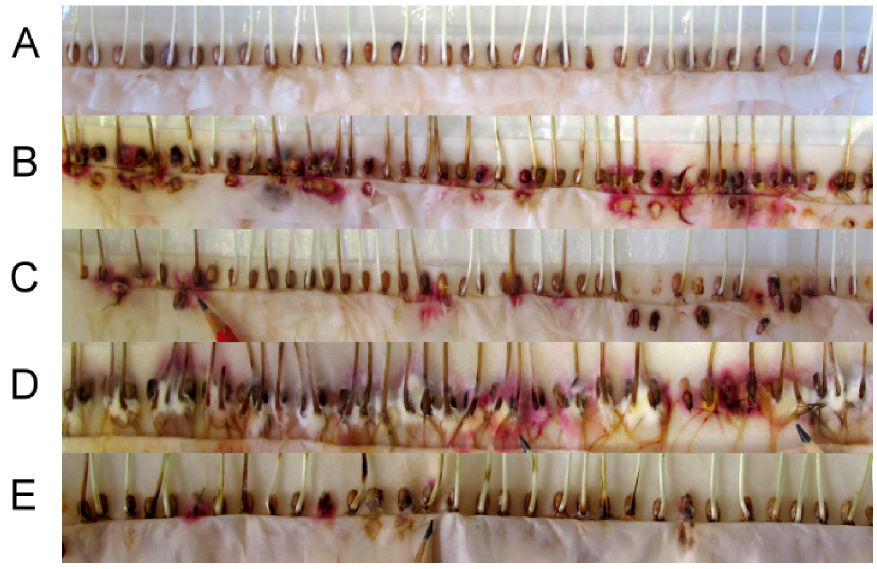
Fig 1. Inoculated and non-inoculated seedlings of cv. Bohemia under different treatment conditions. (A) non- inoculated seedlings in water, (B) inoculated seedlings in water, (C) inoculated seedlings in prochloraz, (D) inoculated seedlings in potassium iodide, (E) inoculated seedlings in sodium bicarbonate. Pink–white coloration around kernels and dark discoloration of coleoptiles and stem bases are symptoms of F . culmorum infection.